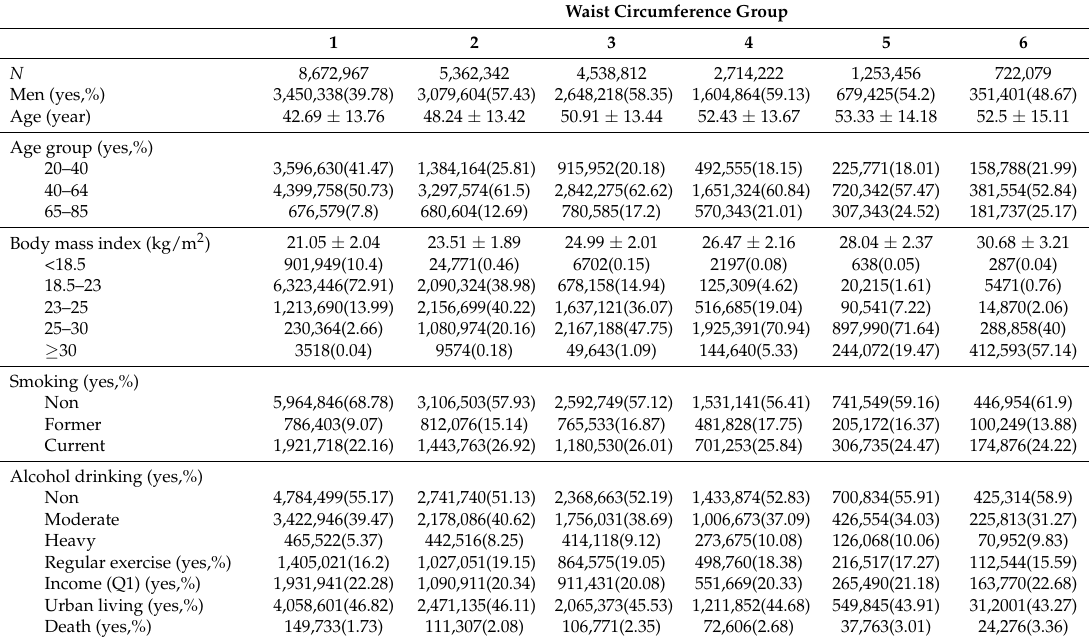
Table 1. General characteristics of participants by waist circumference.